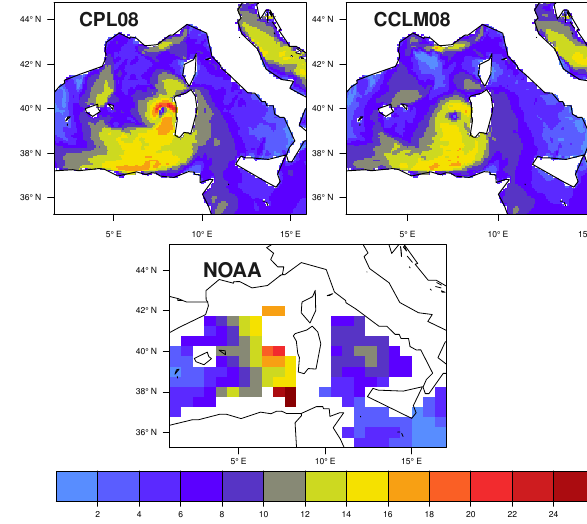
Figure 8. ME09; mean sea level pressure (hPa; dotted contours lines at 2hPa intervals) and temperature ( ◦ C; colored contours at 2 ◦ C intervals) at 700hPa in the coupled and atmosphere-only (0 . 08 ◦ ) simulations and the MERRA reanalysis data on 10 December 1996 at 18:00UTC. Black dots represent track of the medicane.